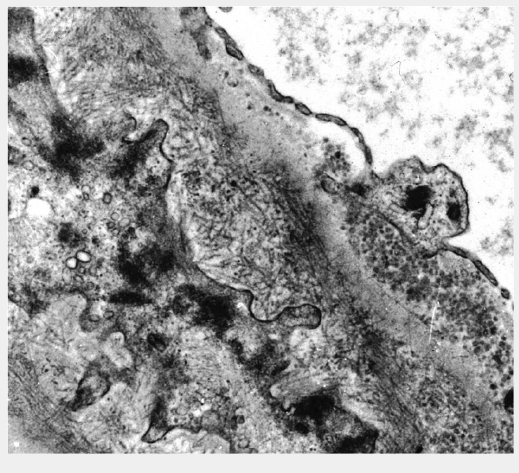
Electron microscopy: peripheral basement membrane with randomly arranged fibrillary